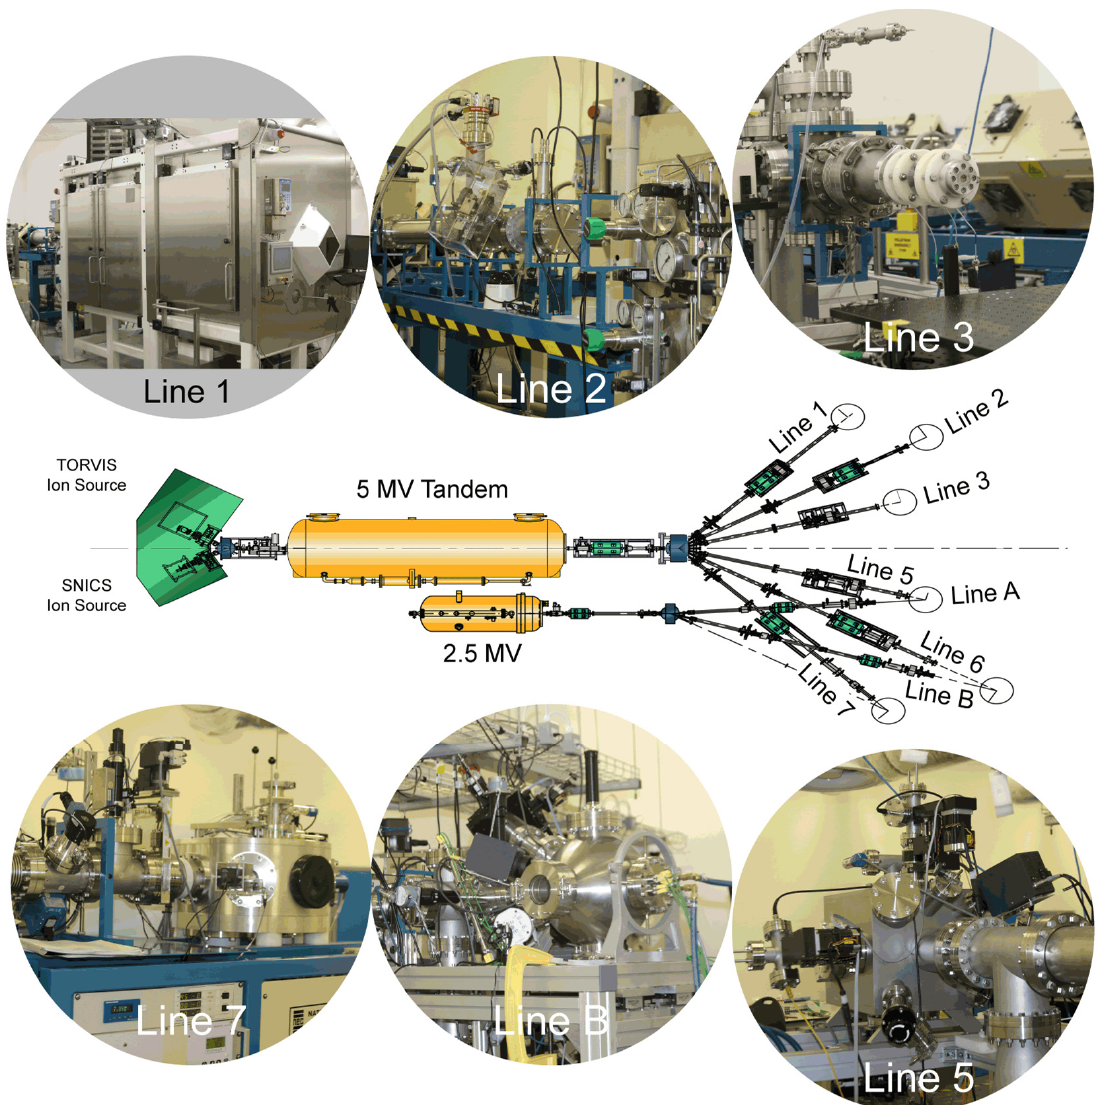
Figure 2. Schematic overview (center) of DCF ion beam accelerators and current suite of experimental end-stations. Line 1 is a radiation hotcell for high-dose proton beam irradiations, with one chamber to house the materials damage vacuum chamber and a second adjacent cell for sample mounting, handling, and storage; Line 2 is for use with separate autoclaves, or to accommodate a user supplied end-station; Line 3 provides ion beam delivery for radiation chemistry experiments, flexibly mounted on an ex-vacuum optical table; Lines 5 and B are for in-vacuum radiation damage experiments using either heavy ions from the 5 MV tandem or light ions from the 2.5 MV accelerator, respectively; Line 7 is the dedicated ion beam analysis end-station.